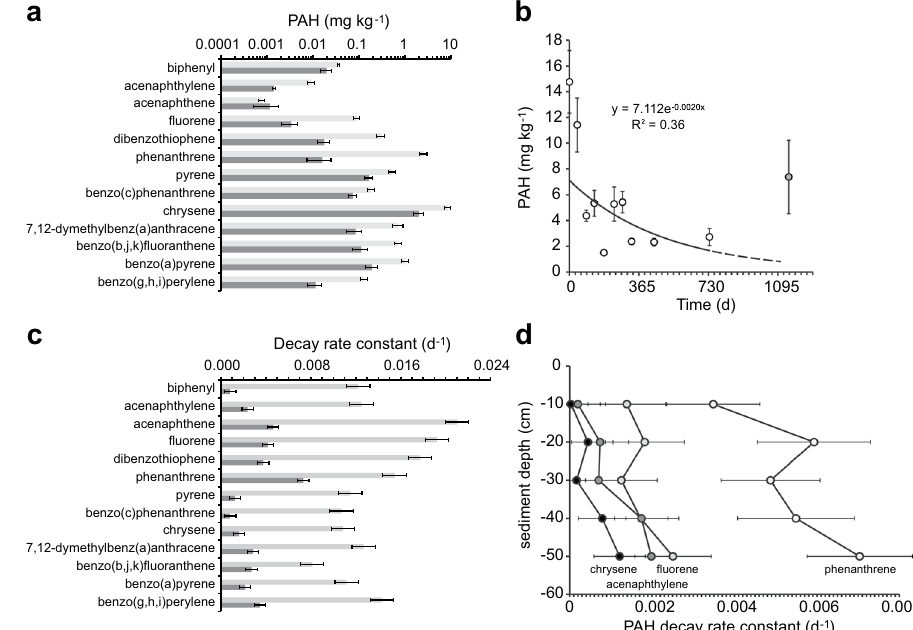
Figure 4. PAH degradation in the sSOAs during the experiment. ( a ) PAH concentrations in the sSOAs at the start of the experiment (light gray) and after 2 years (dark gray). ( b ) Degradation of the total PAHs during the experiment. The PAH concentration of day 1152 (grey fill) was excluded from the regression due to analytical issues. Error bars depict one standard deviation. The dashed line extrapolates the trend based on the 2-year data set. ( c ) PAH decay rate constants averaged over all sediment depths for the initial half-year (light grey bars) and the 2-year period (dark grey bars). Error bars depict standard error. ( d ) Decay rate constants of selected PAHs calculated for the different sediment depths. Error bars depict one standard